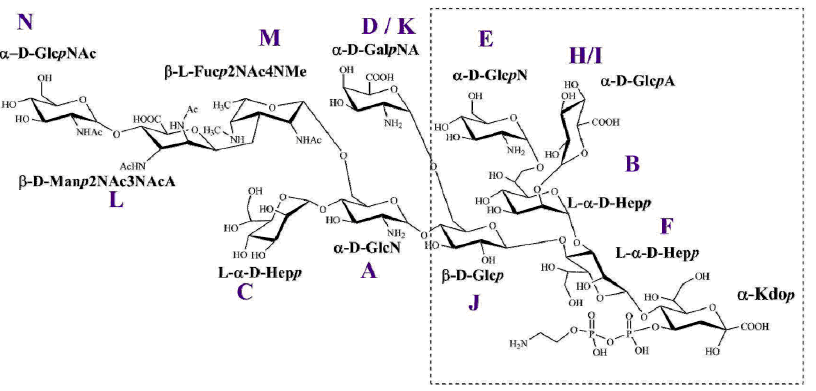
Figure 6. The conserved structural elements among the core oligosaccharides of Bordetellae . The uppercase letters refer to carbohydrate residues. Residues L , M , and N constitute the trisaccharide identified in the B. pertussis 186 LOS. Residues A and C in the LPS of B. bronchiseptica were either not detected or identified at much lower contour levels. Residue D was identified among all LPS of Bordetellae , except for in B. parapertussis 529, in which it was replaced by residue K . The identified “lowest common structural denominator” has been framed with a dashed